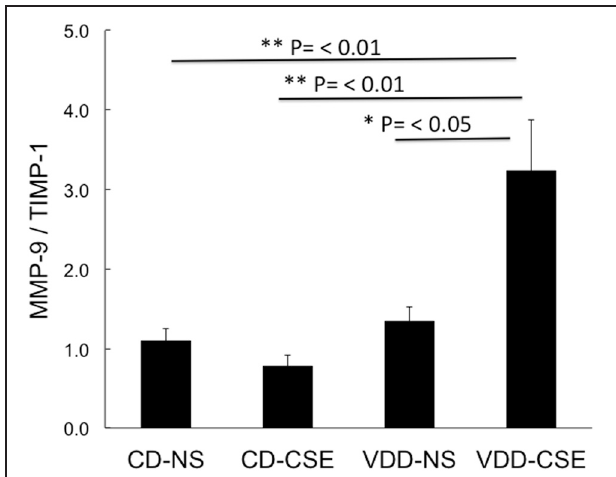
FIGURE 6 | Bars represent the ratio ± SEM of expression of MMP-9 divided by TIMP-1 in each animal studied. Both TIMP-1 and MMP-9 are standardized to expression of the MHK housekeeping gene from whole lung from four to seven mice from each treatment group. Expression of the TIMP-1/MMP-9 ratio was significantly different comparing VDD to VDD-CSE ( p = 0 . 05) and CD-NS and CD-CSE to VDD-CSE ( p = 0 .